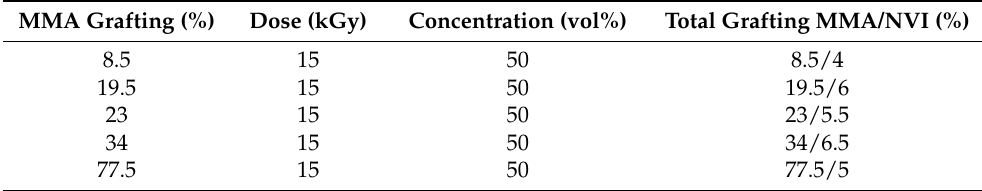
Table 4. (PP- g -MMA)- g -NVI, reaction conditions of NVI grafting by the direct